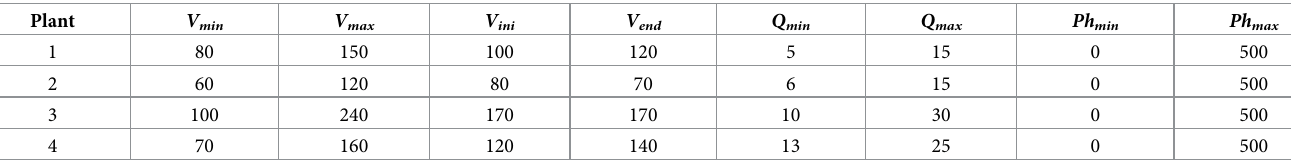
Table 3. Limits of the whole system.